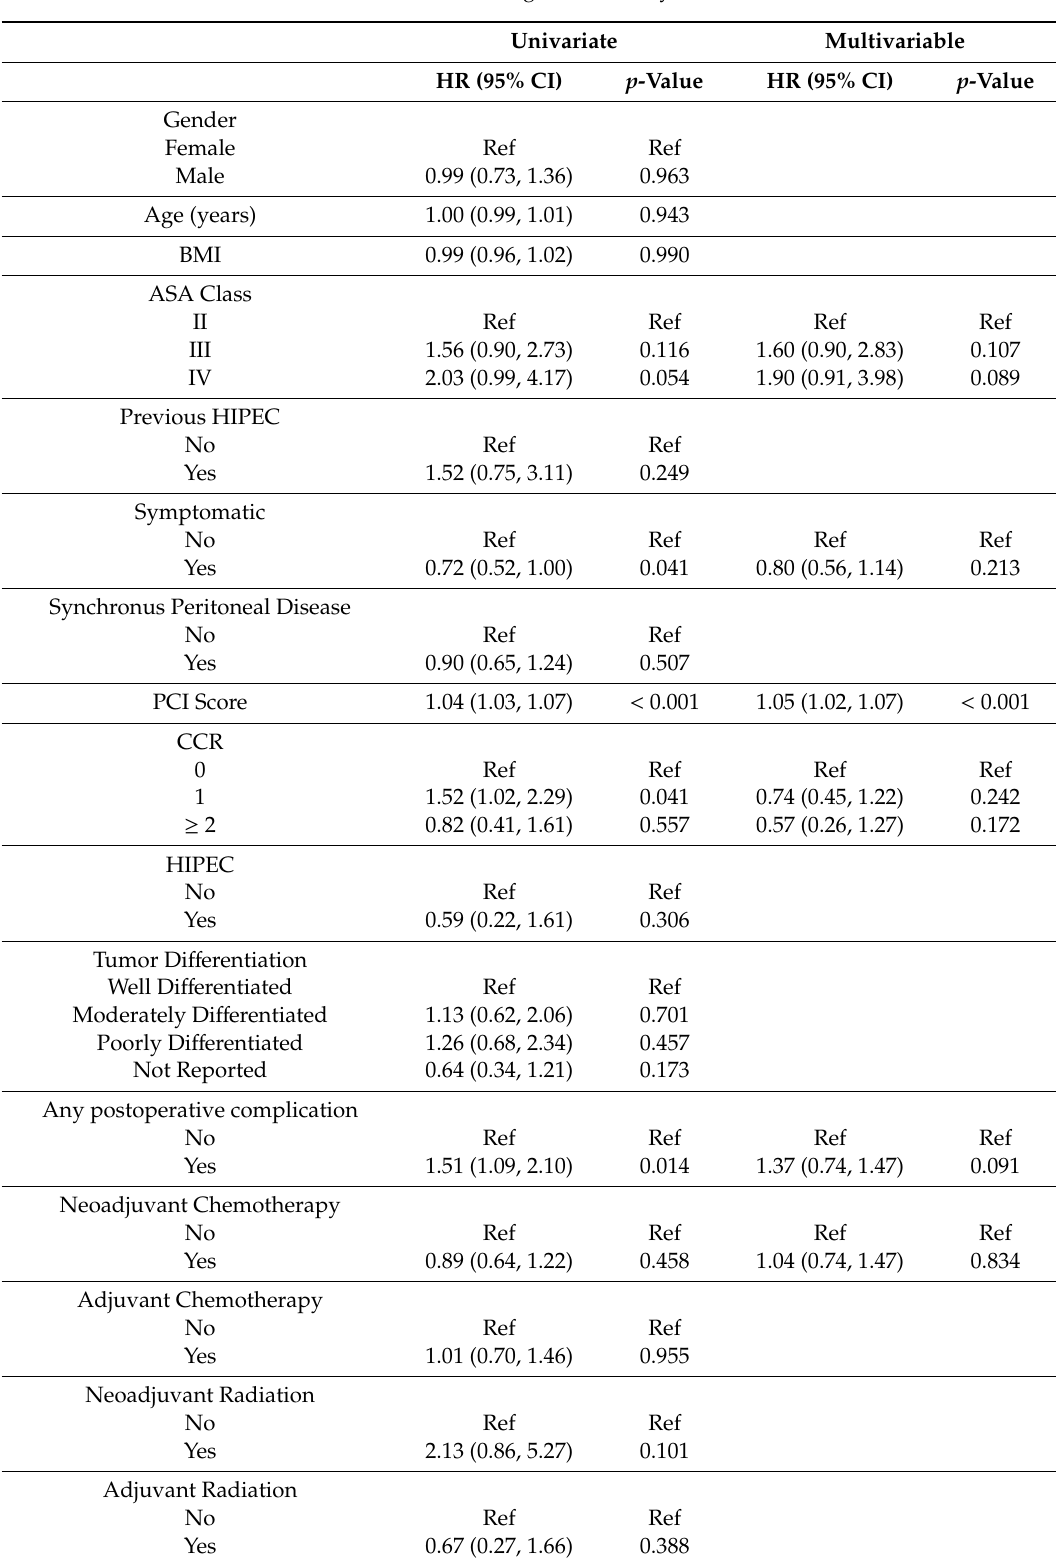
Table 5. Univariate and Multivariable Cox Regression Analysis for Recurrence Free